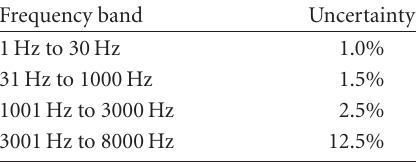
Table 4: Sensors